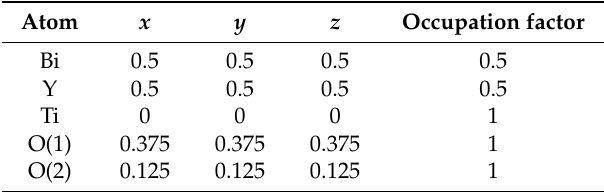
Figure 2. X-ray powder diffraction patterns and Rietveld refinements of BiYTi 2 O 7 (black solid line represents experimental XRD data; red dotted line represents simulative XRD data; green dashed line represents a difference between experimental XRD data and simulative XRD data; and blue vertical line represents observed reflection positions). Table 1. Structural parameters of BiYTi 2 O 7 prepared by solid state reaction method.